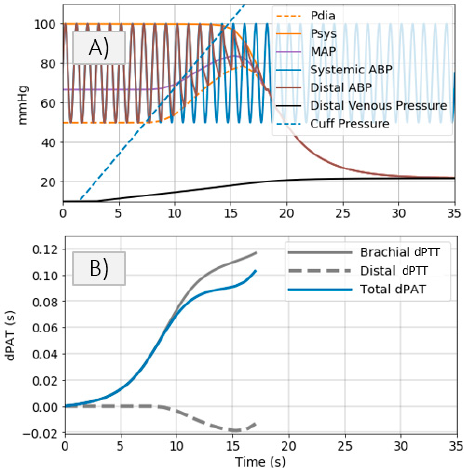
Figure 8. ( A ) Simulated systemic arterial pressure, cuff pressure and resulting distal arterial and venous pressure. ( B ) Simulated total Δ PAT , Δ𝑃𝑇𝑇 (cid:3029)(cid:3045)(cid:3028)(cid:3030)(cid:3035)(cid:3036)(cid:3028)(cid:3039) , and Δ𝑃𝑇𝑇 (cid:3031)(cid:3036)(cid:3046)(cid:3047)(cid:3028)(cid:3039)